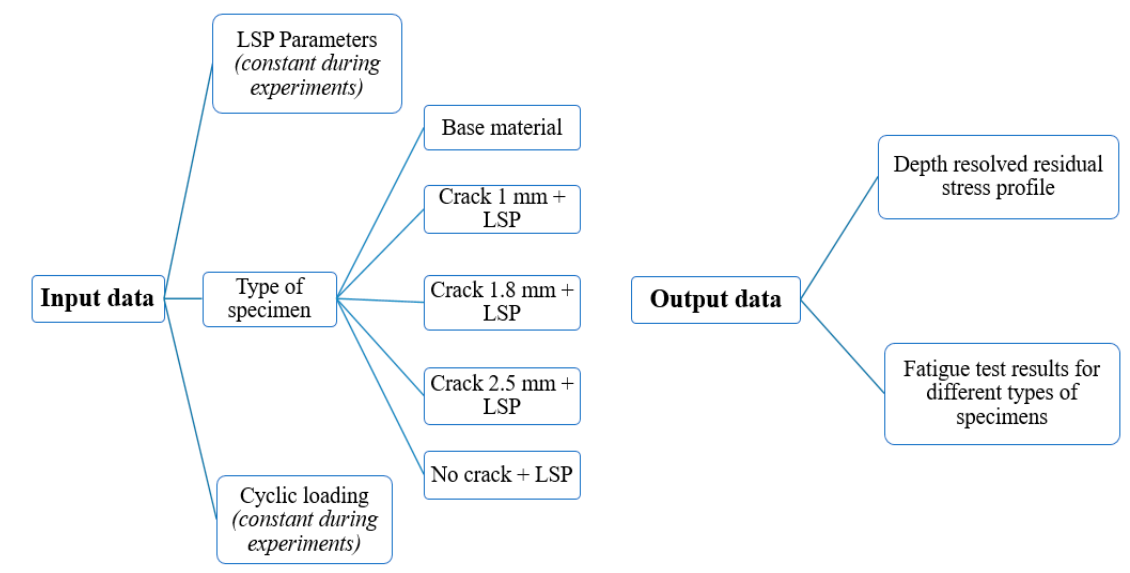
Figure 3. Block scheme of used experimental program.